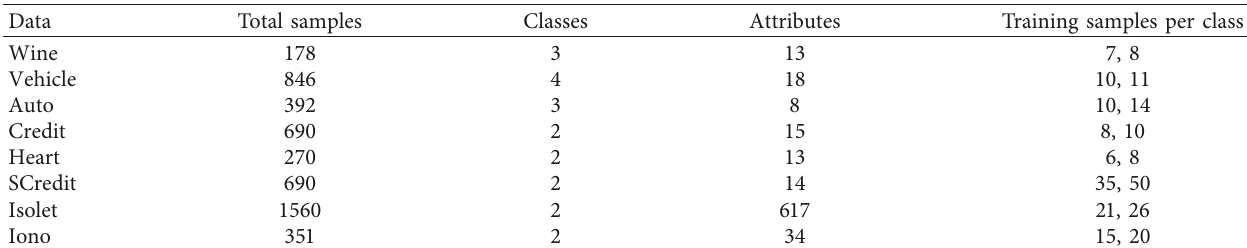
Table 2: The main information about the used UCI data set.